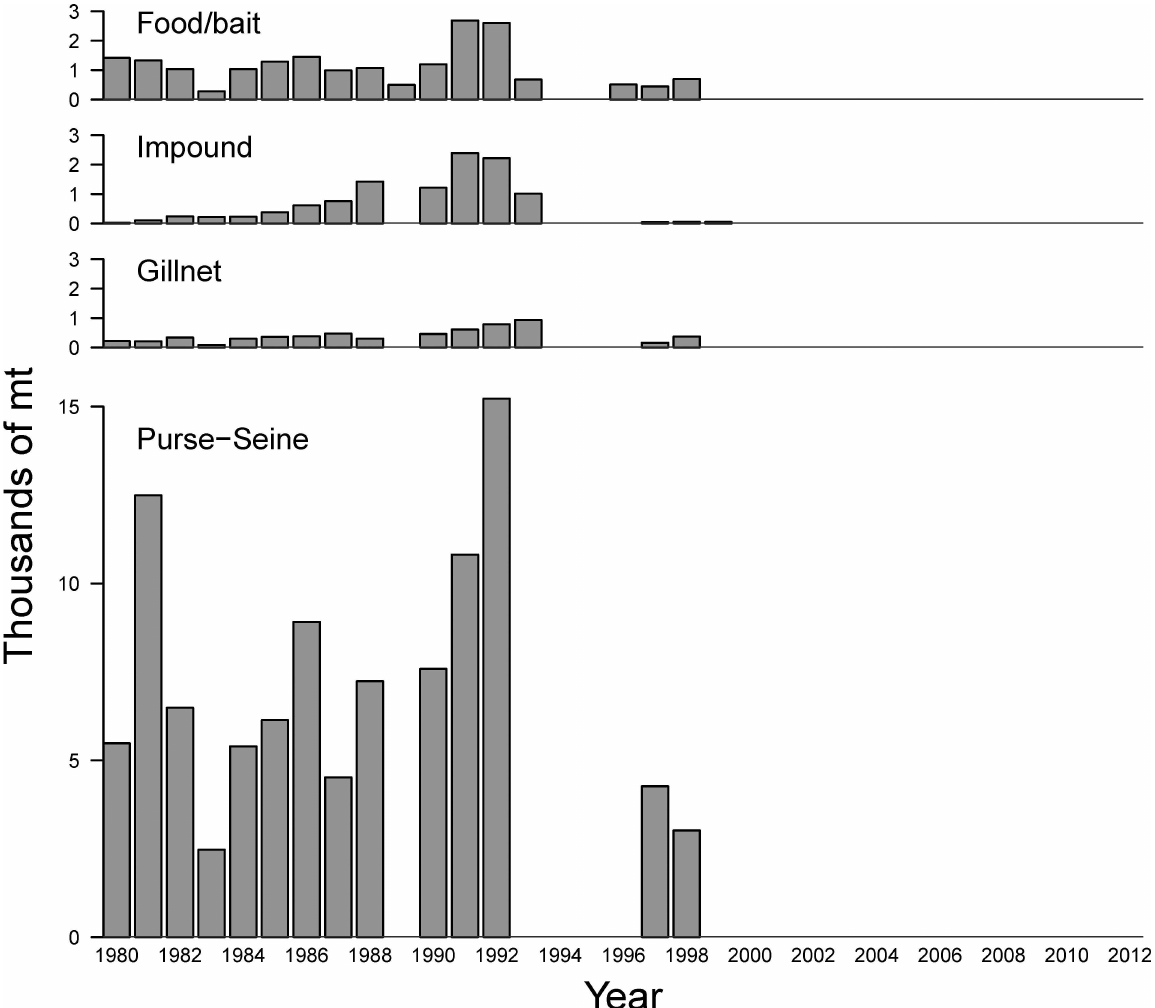
Fig 3. The four types of annual catch data, in thousands of metric tons, for Prince William Sound herring used in the Bayesianage-structured assessment model. Data for the three fisheries in the top panels are in the form of numbersof catch-at- age, so these were convertedto annualtotal yield in mt using the weight-at-age (mt) data (1.7) for ease of display. Absent bars denote years that fishery did not run; all herringfisheries have been closed since